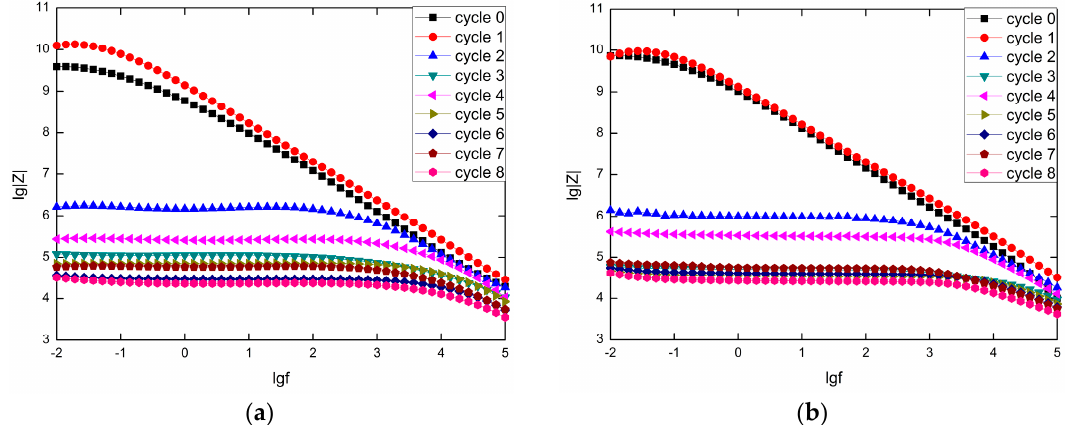
Figure 5. Impedance modulus spectrums of the specimens: ( a ) Plate 1#; ( b ) Plate 2#.